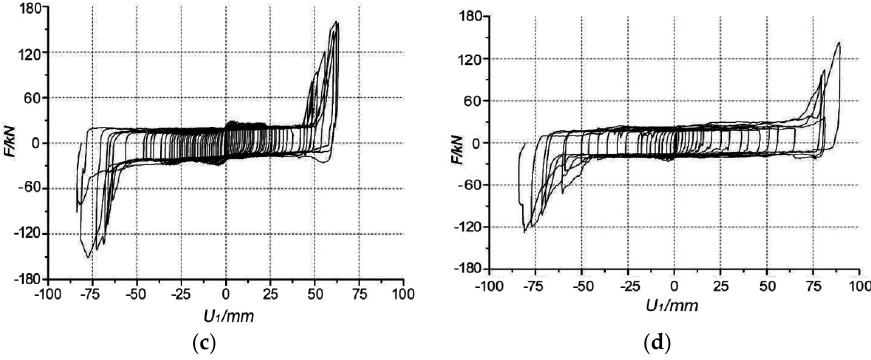
Figure 15. F ‐ U 1 hysteretic curves. ( a ) GGBW ‐ 1; ( b ) GGBW ‐ 2; ( c ) GGBW ‐ 3; ( d ) GGBW ‐ 4. Figure 15. F-U 1 hysteretic curves. ( a ) GGBW-1; ( b ) GGBW-2; ( c ) GGBW-3; ( d ) GGBW-4.